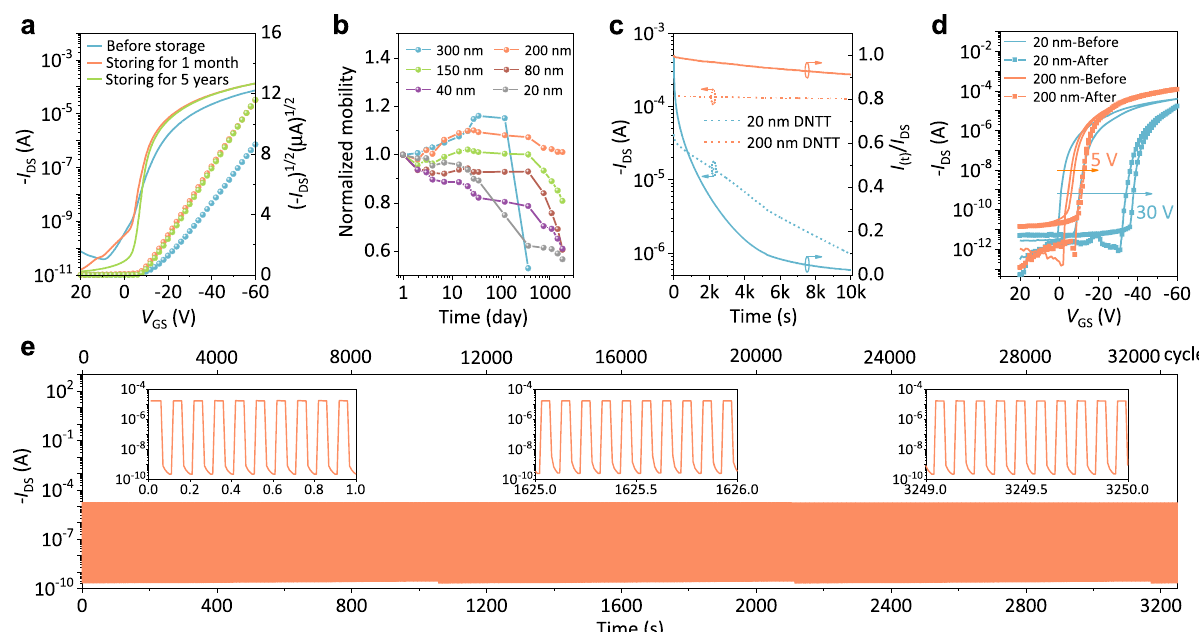
Fig. 3 Effect of thickness-dependent strain on OFET stability. a Transfer curves of the 200 nm DNTT OFET before storage and after storage for 1 month and fi ve years. V DS = − 60 V. b Variation in the normalized mobility of OFETs with different thicknesses during the fi ve-year storage period. c The bias stress effect tests of the 200 and 20 nm devices after fi ve years of storage. I ( t )/ I DS (the solid line) denotes the ratio of the drain current at different times ( t ) to the initial drain current value ( I DS ). V DS = − 60 V, V GS = − 60 V. d Transfer curves of the 200 and 20 nm DNTT OFETs before and after the bias stress test. 5 and 30 V represent the threshold voltage shift. V DS = − 60 V. The arrows denote the shift direction. e The 32,500 cycle switching tests of the 200 nm DNTT OFET after fi ve years of storage (test frequency = 10 Hz, V DS = − 30 V, V GS = − 30 and 0 V, alternately). The channel length and width of the tested OFETs are 100 and 1000 μ m, respectively.